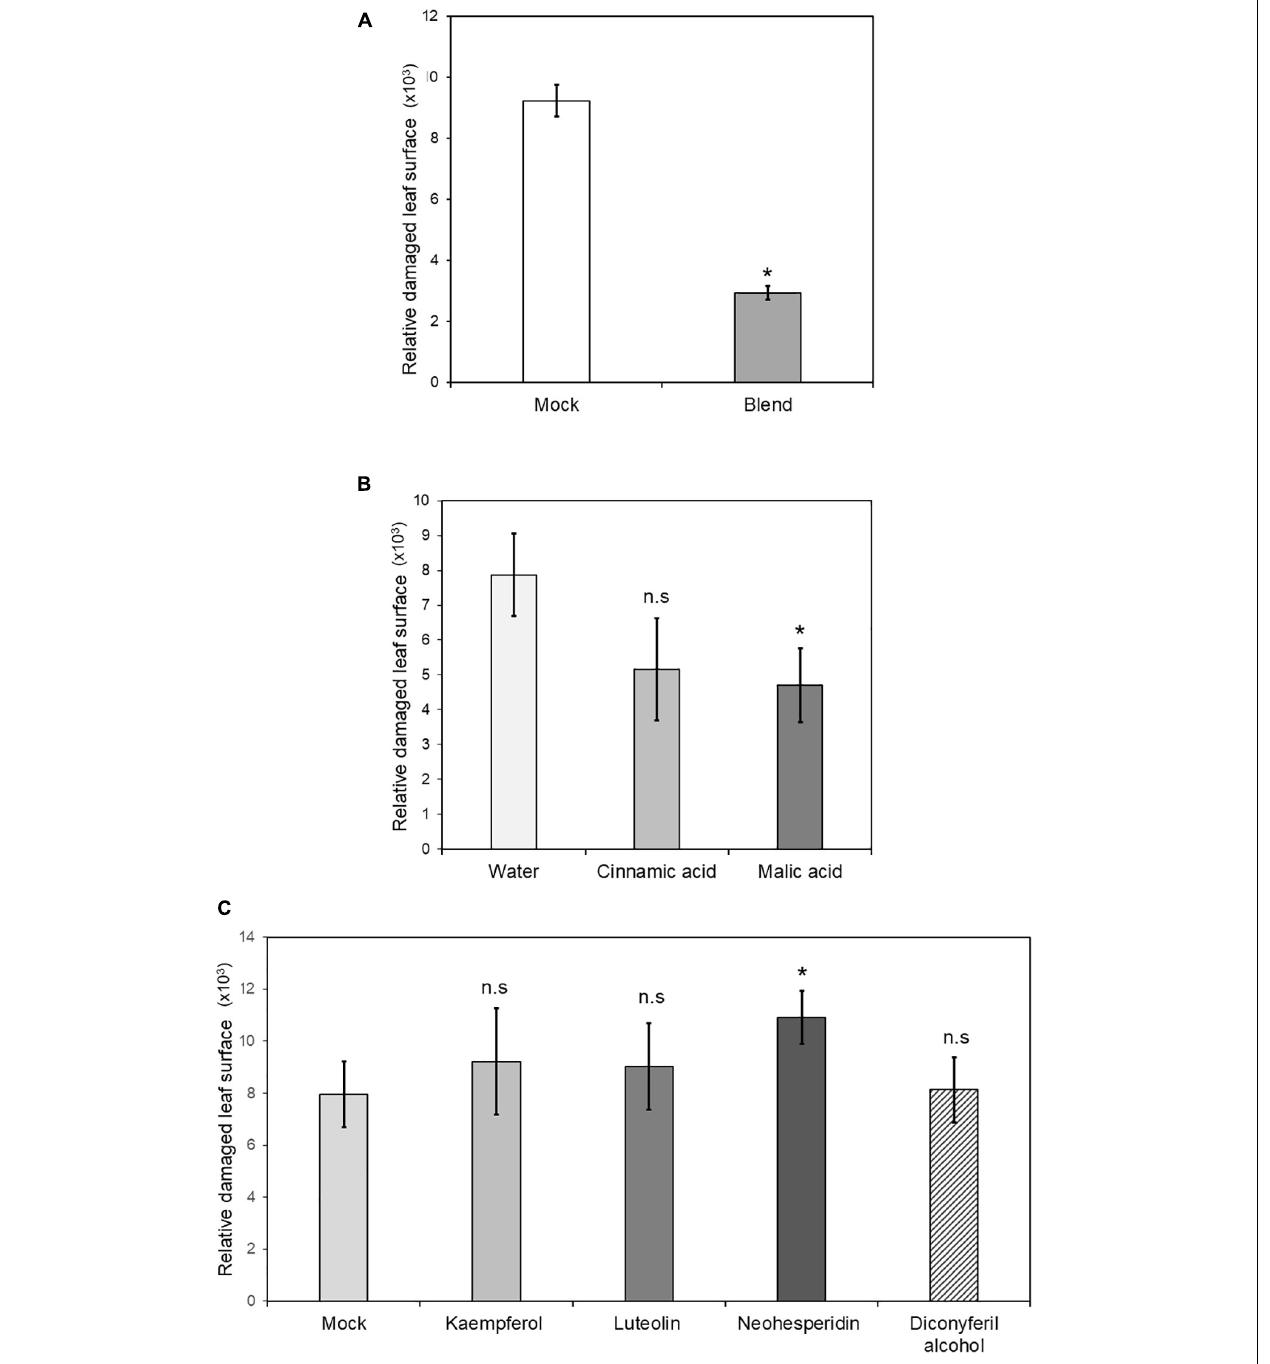
FIGURE 8 | Induced resistance by chemical treatments of priming compounds. Four non-mycorrhizal C. aurantium plants were infested with 5 T. urticae per leaf (two leaves per plant) after foliar application with either malic acid, cinnamic acid, kaempferol, luteolin, diconyferil alcohol, neohesperidin or a blend of all of them. Treatments were grouped depending on the control (A) 1% DMSO, (B) , water (C) 1% DMSO. Infested leaves were detached and scanned to estimate damaged leaf surface as described above. The experiment was repeated three times. Asterisks indicate significant differences at P < 0.05 (GLIM, n =